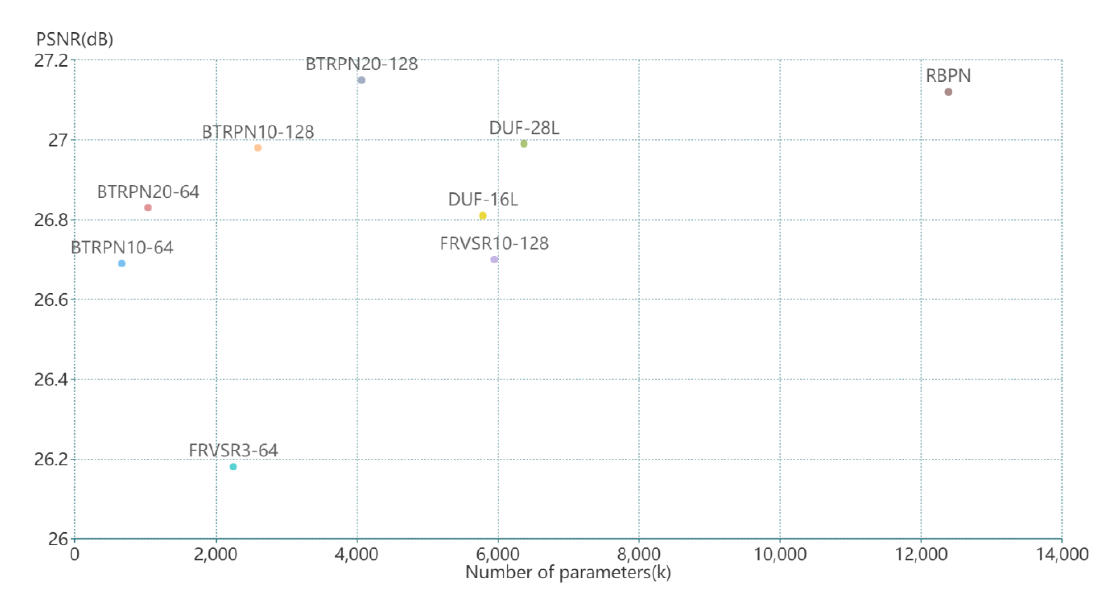
Figure 11. Parameters of different models for 4x VSR on the VID4